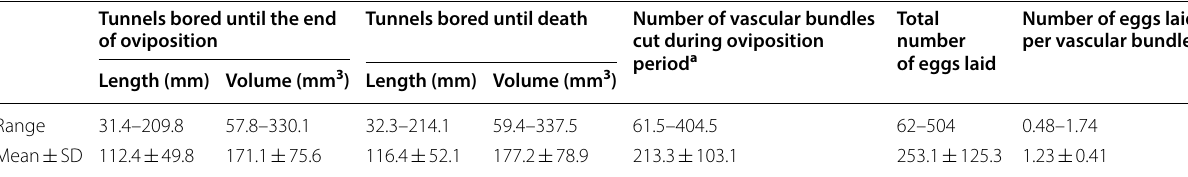
SD standard deviation a One vascular bundle was deemed equivalent to two metaxylem vessels